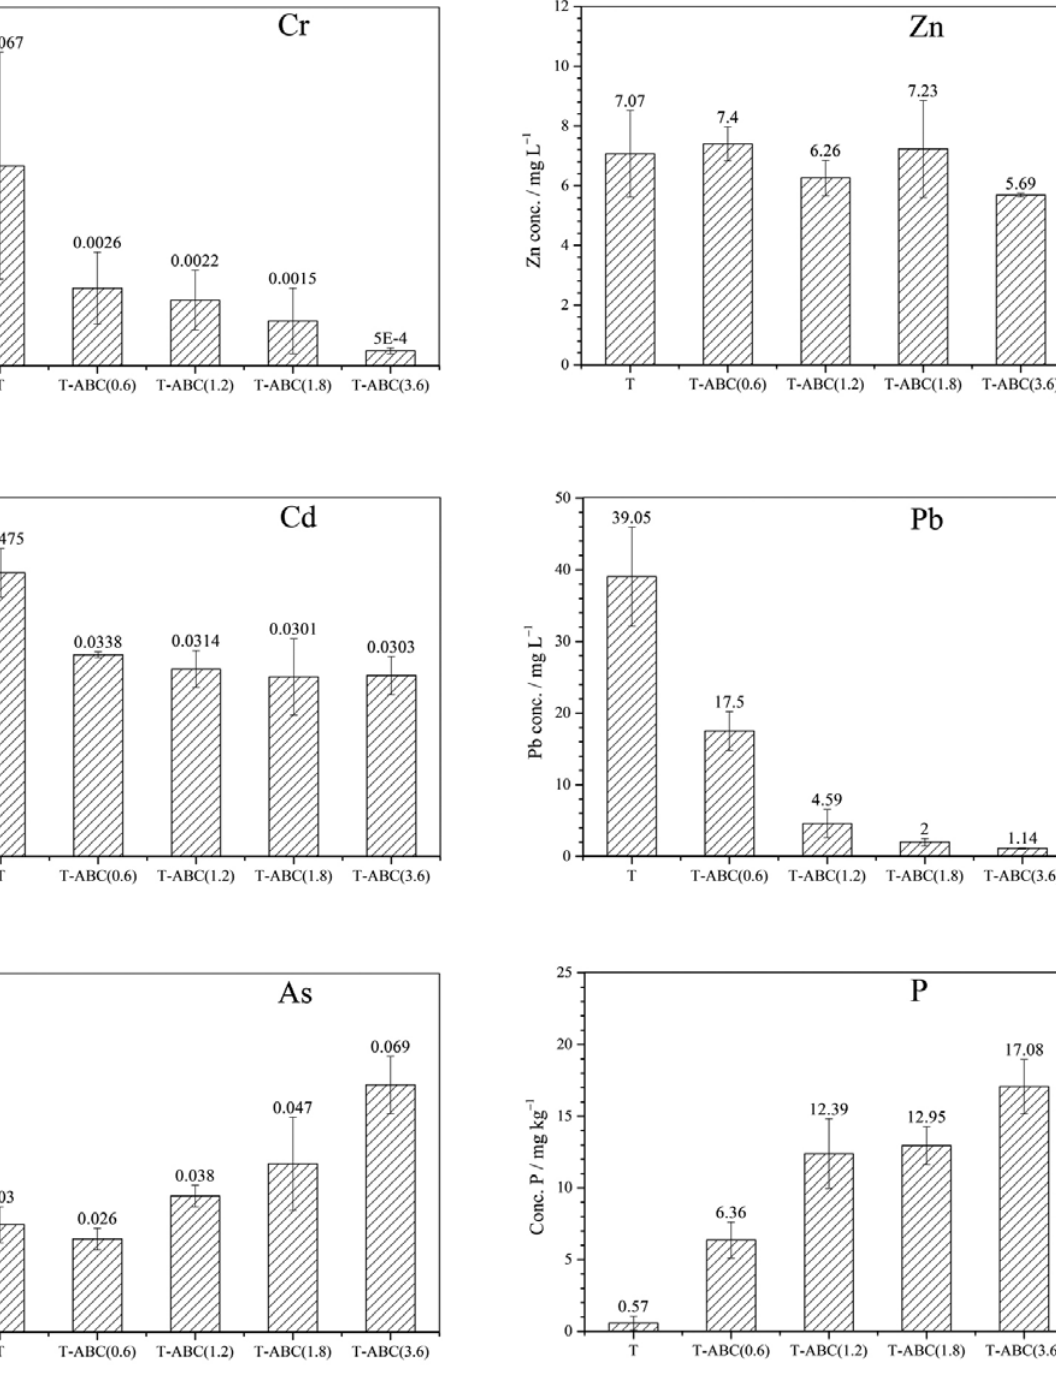
Fig. 2. TCLP concentrations of metals (in mg L –1 ) and the mobility of P (in mg kg –1 ) of the tailings and mixtures. Results are presented as the ave- rage of three replicates with standard deviations as the error